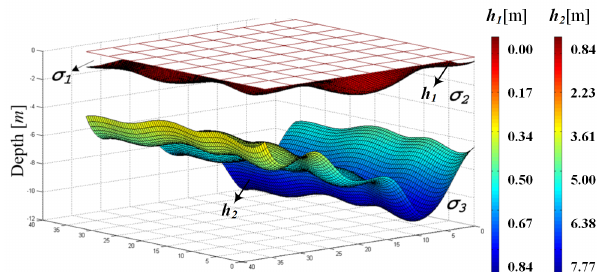
Figure 24. View of 3D mapping for profile of Nitisol.